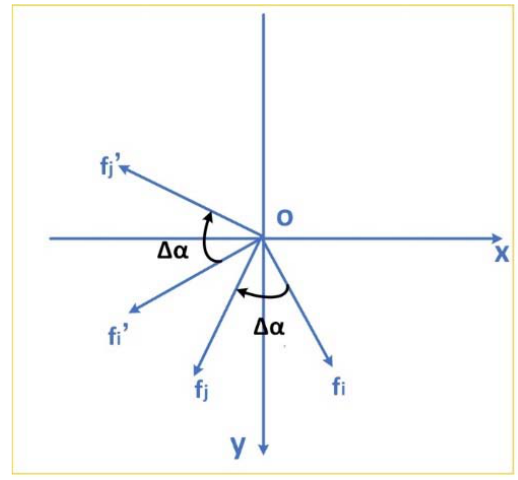
Figure 4. ( a – d ) Histograms of horizontal shifts, vertical shifts, scale ratio, and main direction difference.